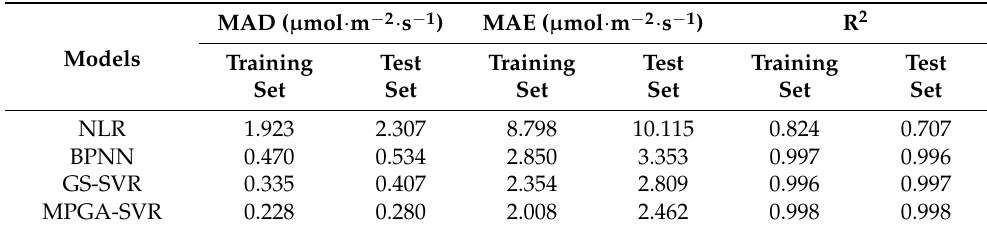
Table 5. Validation of the photosynthetic rate model for the whole growth period of cucumber on the testing set.